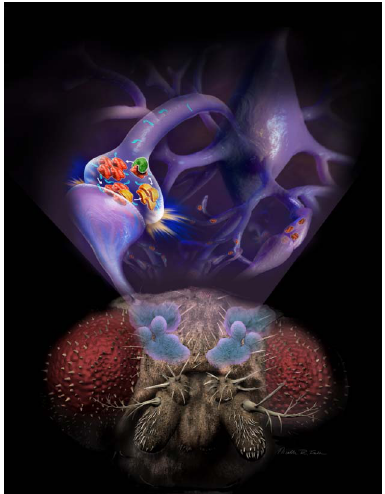
Selected PLOS Biology research articles are accom- panied by a synopsis written for a general audience to provide non-experts with insight into the significance of the published